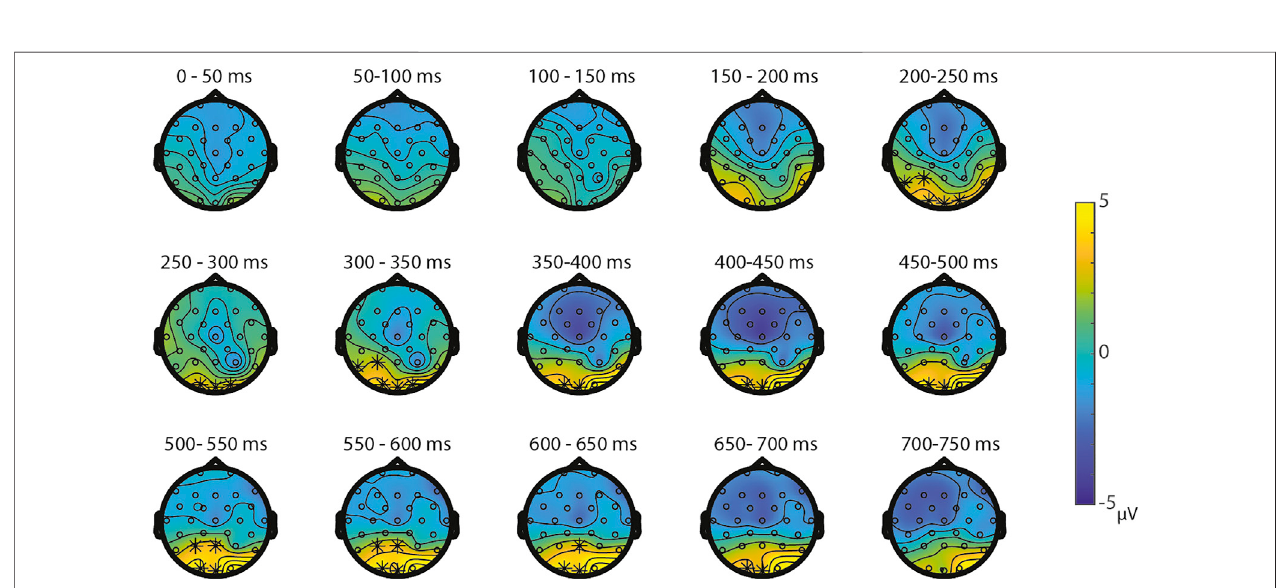
FIGURE 10 | Topoplots of the differences between the symbolic targets in the NsS-task and the SS-task with asterisks representing signi fi cant differences based on α (cid:1) 0.05.